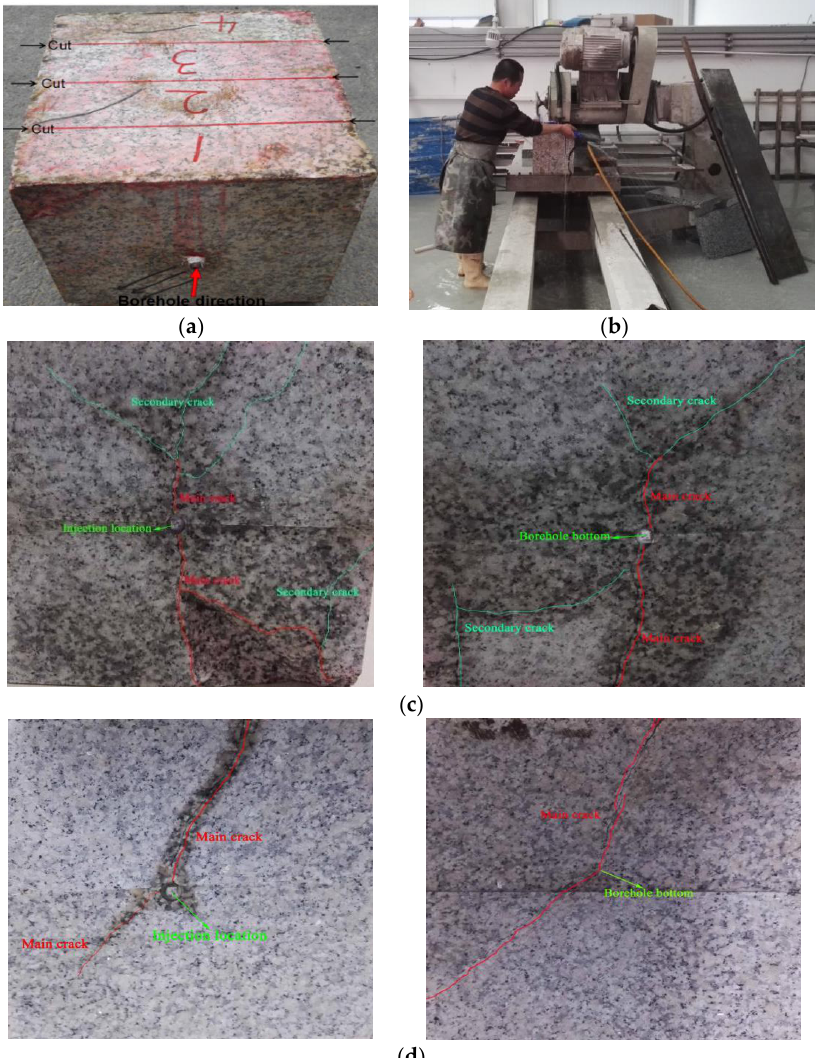
Figure 16. ( a ) Schematic diagram of the cutting method; ( b ) cutting process of the sample after fracturing; and ( c , d ) crack characteristics inside the monzogranite specimens (MG-4 and MG-6) after fracturing.